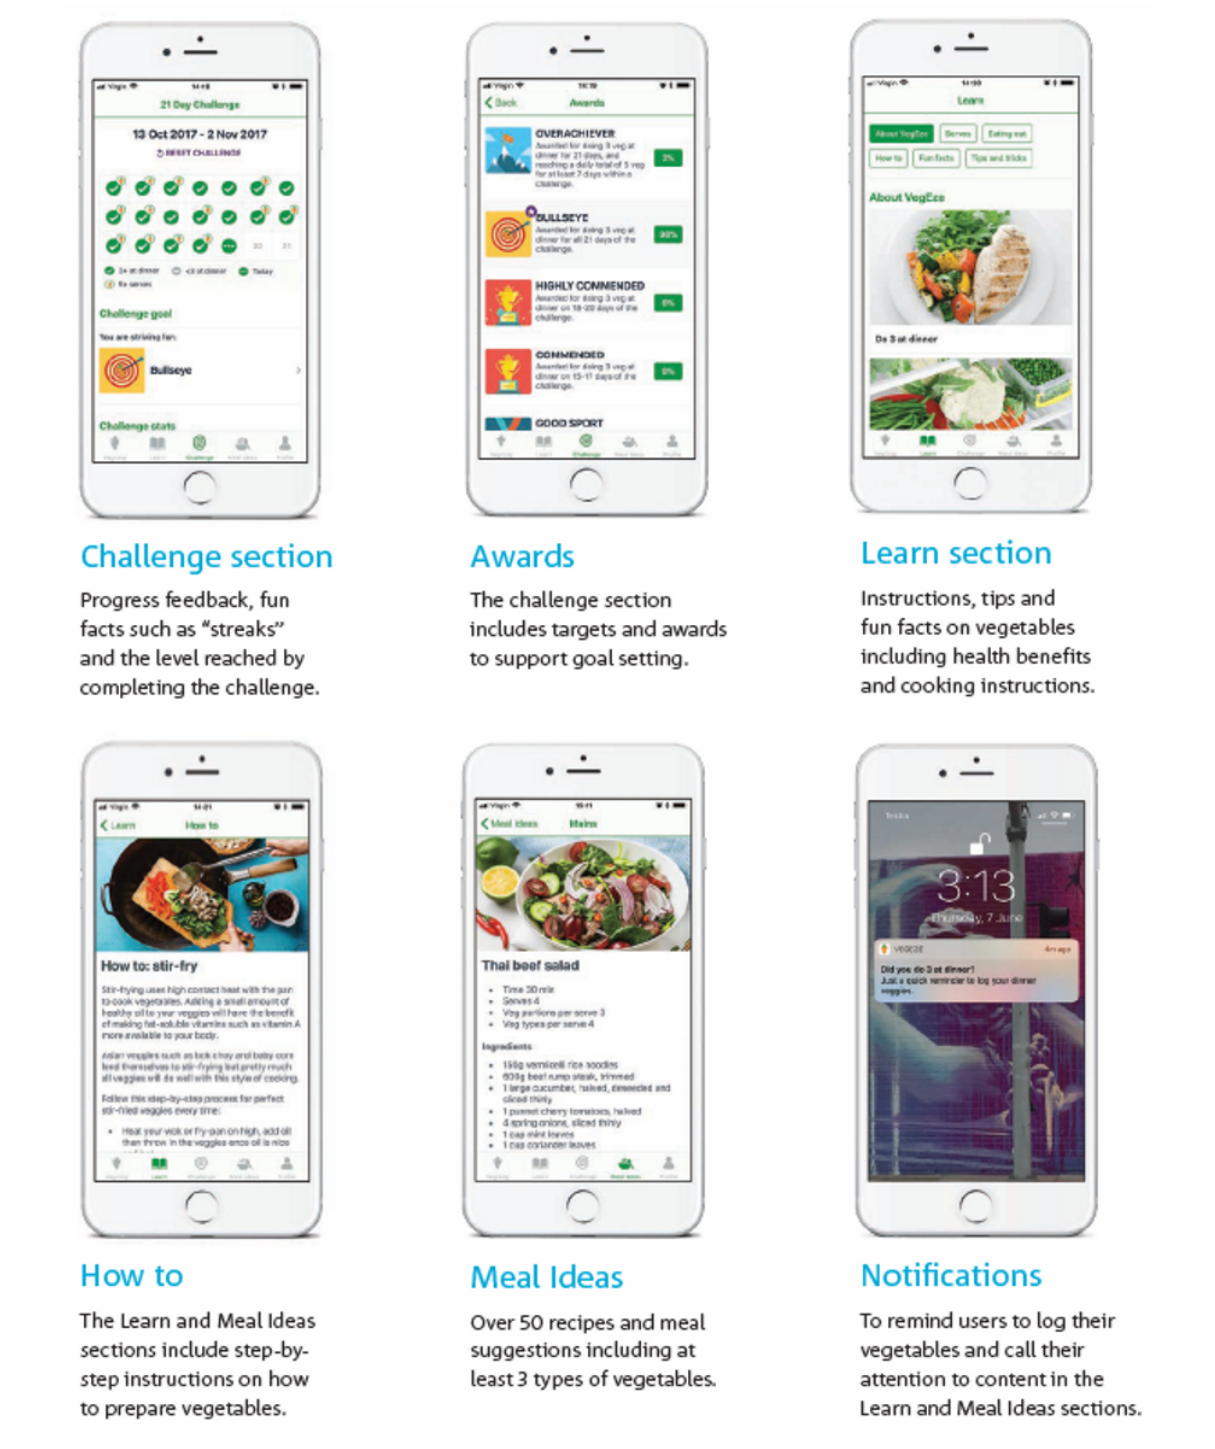
Figure 2. Other features of the VegEze